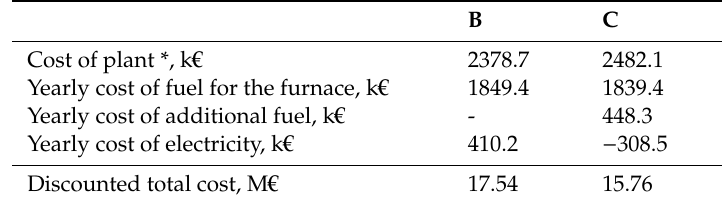
Table 4. Comparison of cost assessment results for two considered oxy-fuel